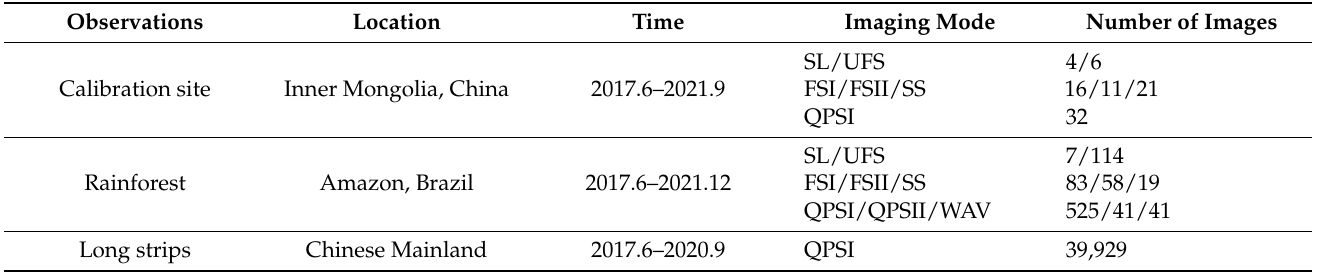
Table 1. Time-series observations for the GaoFen-3 system’s radiometric and polarimetric validations.